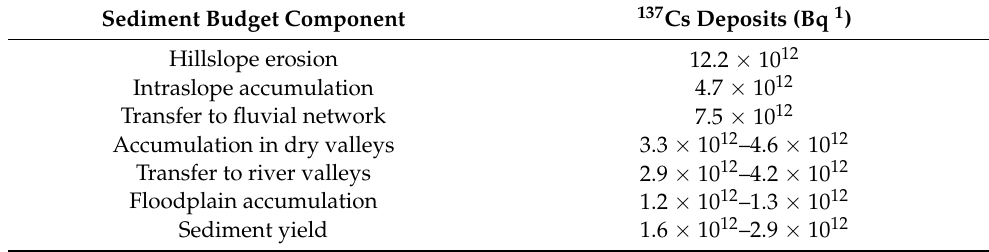
Table 8. Distribution of 137 Cs deposits between different sediment budget components of Plava River basin in